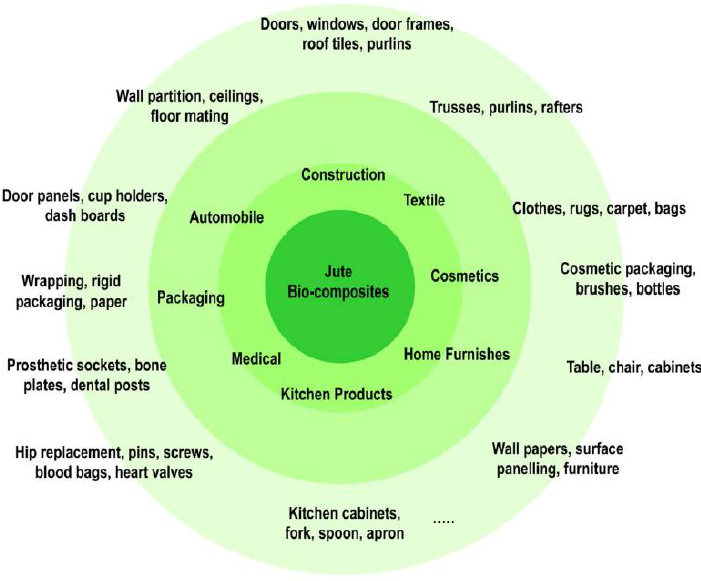
Figure 6. Applications of jute-based